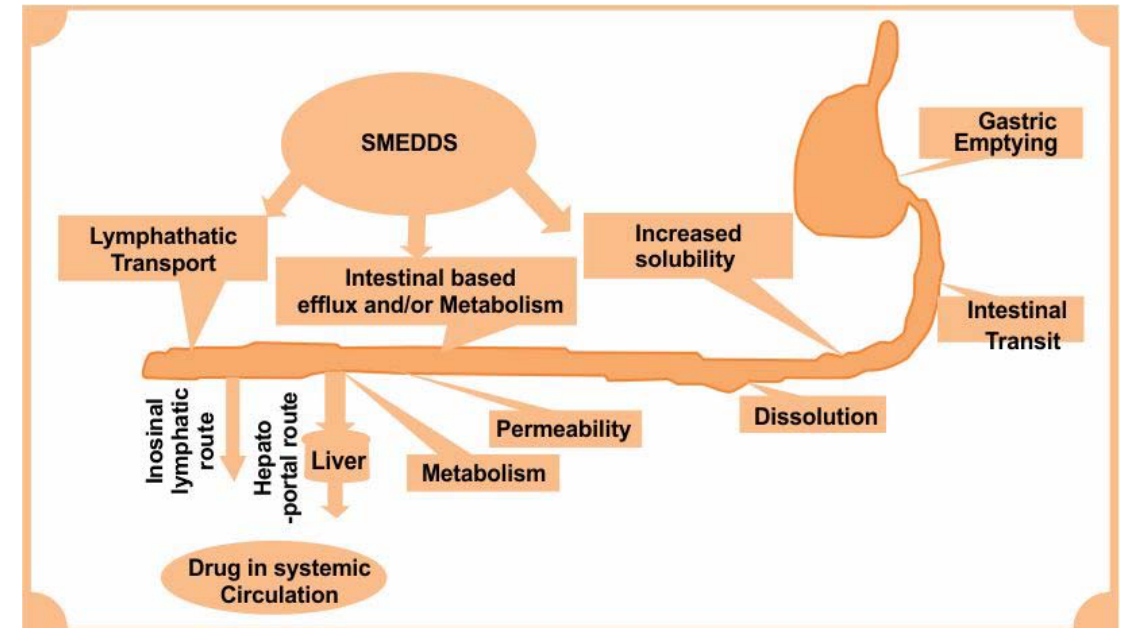
Fig. 1 explain the mechanism of action of oral admin- istration of SMEDDS on oral administration of drug [5].